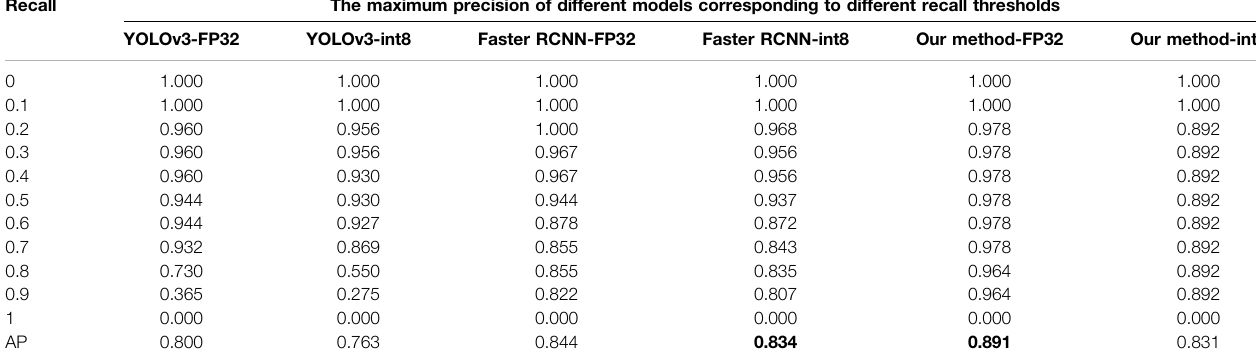
TABLE 4 | The detection accuracy of different method for insulator icing level_1 before and after compression.